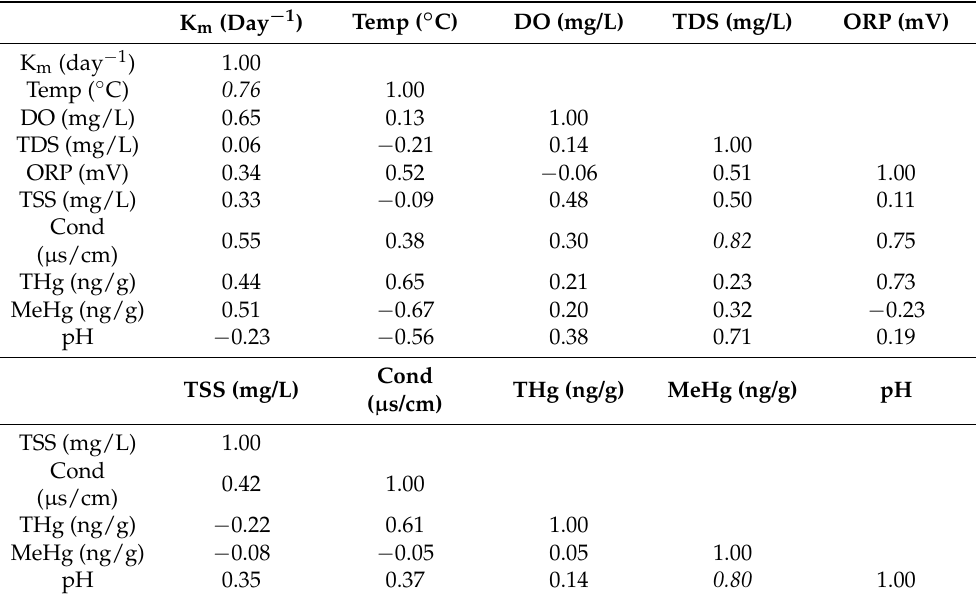
Table 5. Pearson’s correlation matrix for water quality parameters measured in seasonal trends for Sky Lake, Mississippi, open water, and wetland sites. Correlations with p -values < 0.05 are italicized. K m (Day − 1 ) Temp ( ◦ C) DO (mg/L) TDS (mg/L) ORP (mV) K m (day − 1